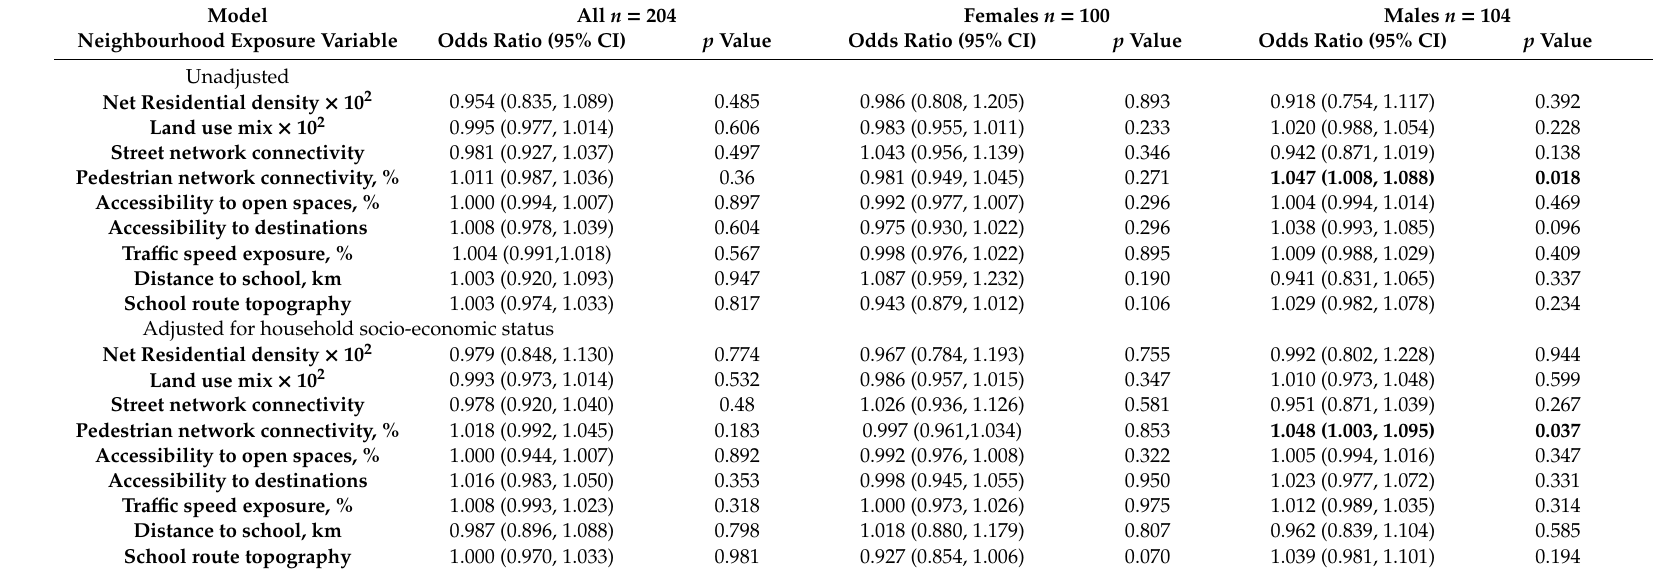
Note: bold signifies significant at p <